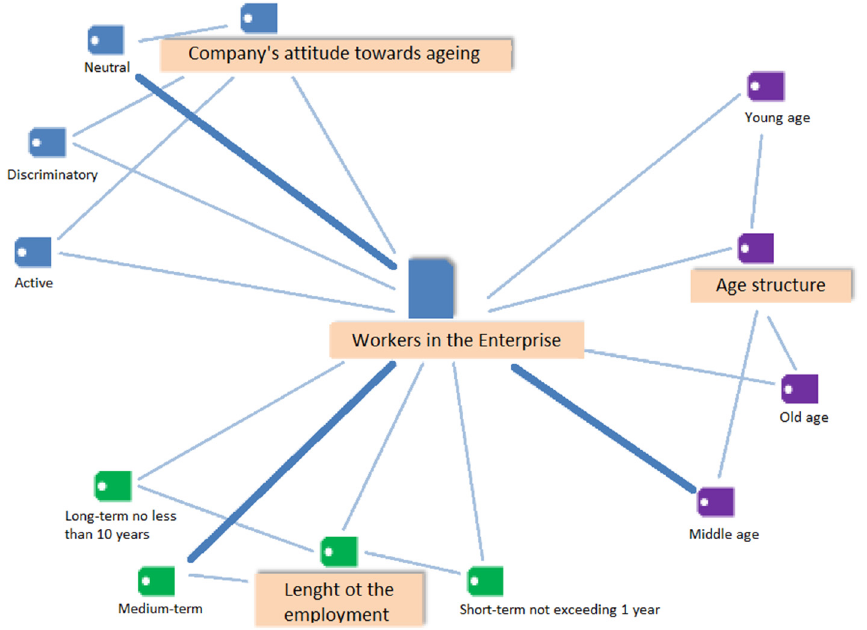
Figure 3. The map of the workforce distribution in the company. Source: authors.